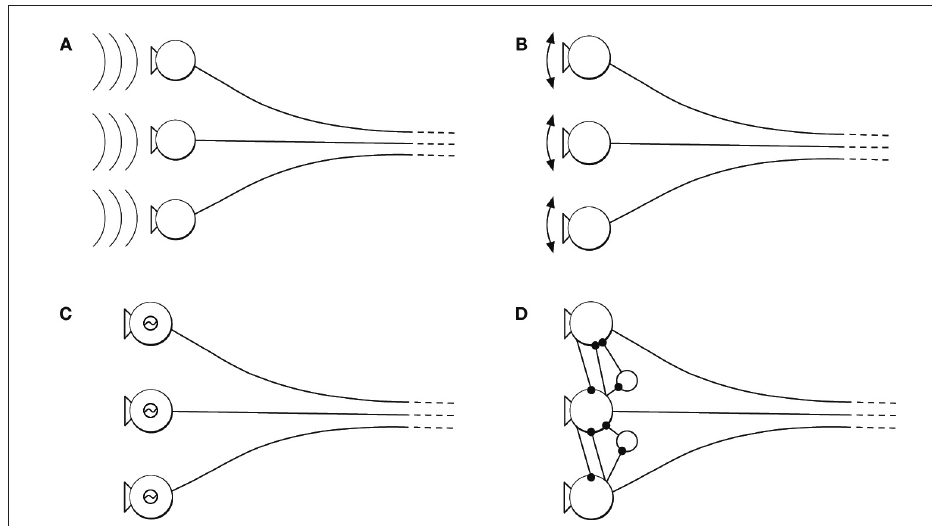
Figure 2 | Origin of neural oscillations. (A) Oscillatory stimulus. (B) Oscillatory sensor movements (driven or resonance). (C) Oscillation from electrical resonance of individual cells. (D) Oscillatory intrinsic network activity due to recurrent network